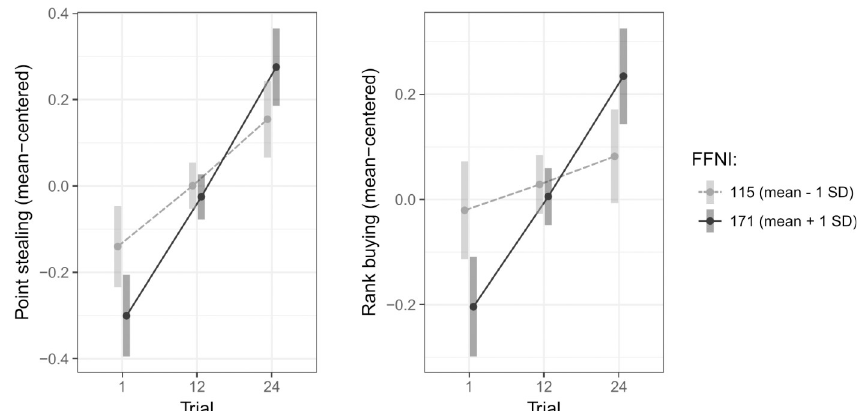
Fig 3. Significant narcissism � trial interactions predicting point stealing (left) and rank buying (right) indicating that more narcissistic individuals tended to increase both behaviors in response to the cumulative experience of defeat. The above effects were robust to subject-level covariates (age, sex, education, ethnicity, household income, game experience and depression). Points are estimates from the corresponding regression model at the indicated values; vertical bars represent 95% confidence intervals. Legend: FFNI, Five-Factor Narcissism